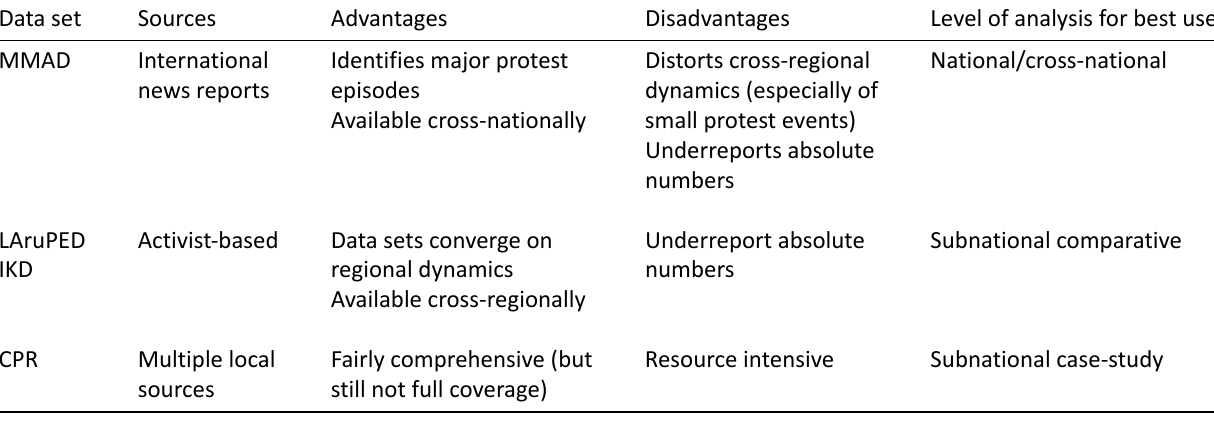
Table 5. Advantages and disadvantages of data sets compared in the analysis. Data